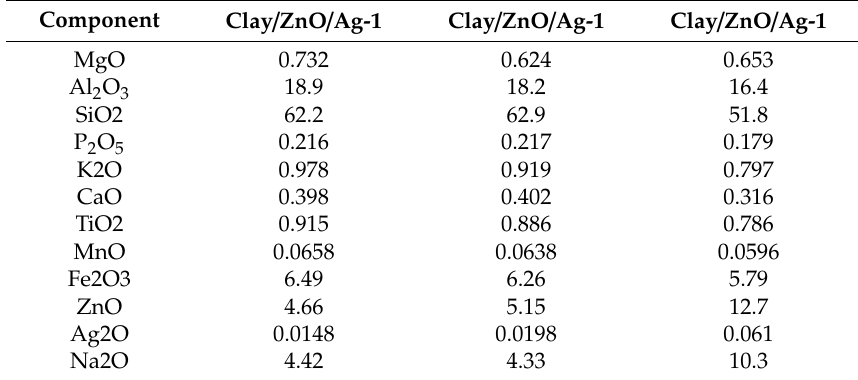
Table 4. XRF analysis of the components of clay / ZnO / Ag samples: clay / ZnO / Ag-1, clay / ZnO / Ag-2 and clay / ZnO / Ag-3 nanocomposites (in